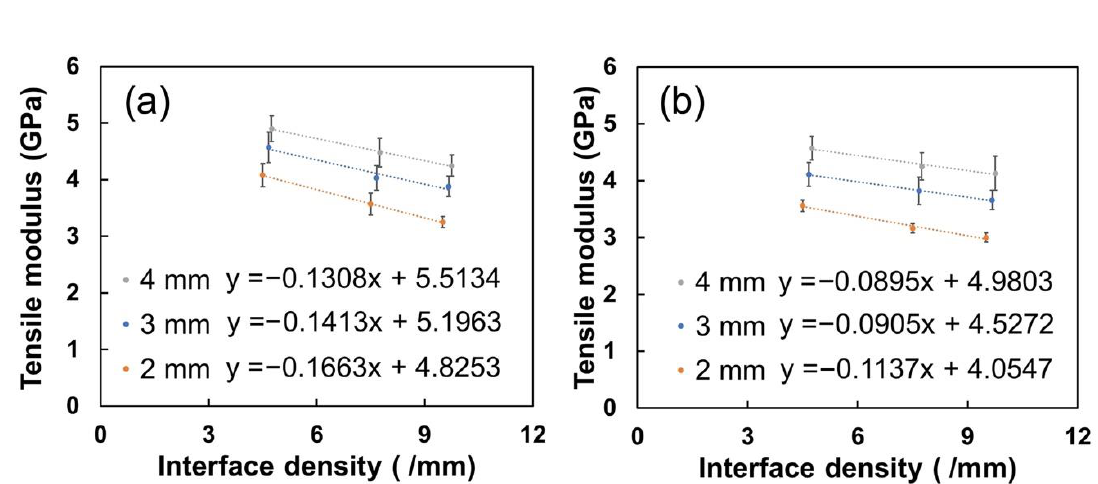
Figure 10. The tensile modulus of the printed SFRN samples as a function of interface density: ( a ): [0, 90] SFRN; ( b ): [+45, − 45] SFRN.